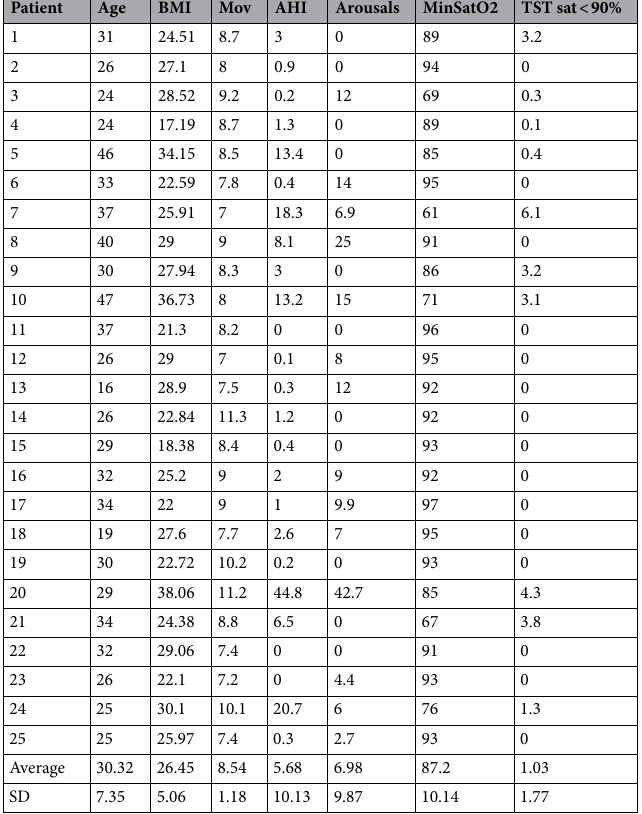
Table 1. Characteristics of patients selected from the SARME group. Age: years; BMI: kg/m 2 ; Mov. Millimeters; AHI: number per hour; Arousal: number per hour; MinSat O2 : percentage; TST sat < 90%: percentage of the total time of sleep; SD: standard